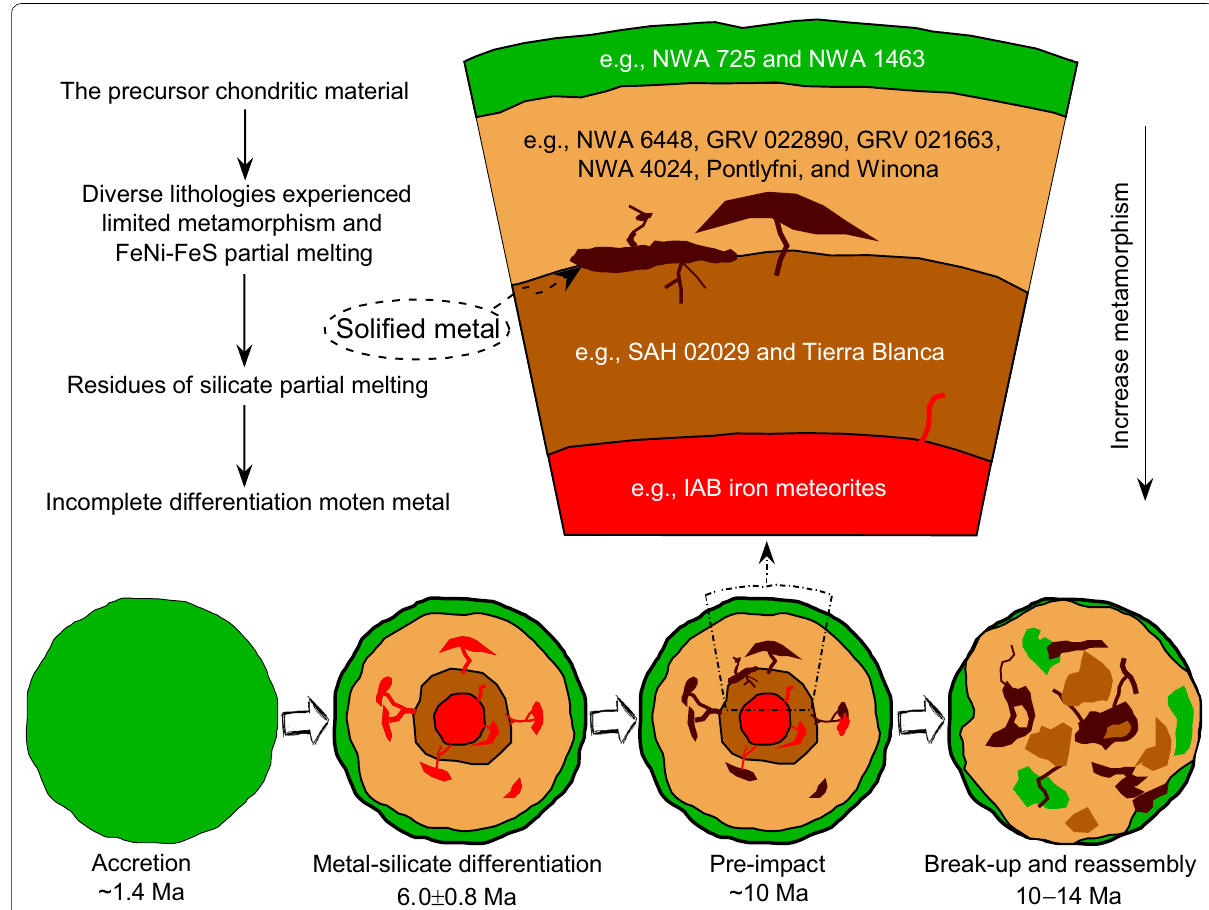
Fig. 7 The propositional layered structure of winonaite parent asteroid (Benedix et al. 2000; Hunt et al. 2018). The highly diverse textures and mineralogies of winonaites suggest a four-layered structure on the early winonaite parent asteroid (i.e., prior to the catastrophic impact breakup event): (1) surface layer consisting of precursor chondritic materials (e.g., NWA 725 and NWA 1463; Benedix et al. 1998); (2) subsurface layer composed of diverse lithologies that experienced limited metamorphism and FeNi–FeS partial melting (e.g., NWA 6448 and Pontlyfni; Floss et al. 2008); (3) deep residues of silicate partial melting (e.g., SAH 02029 and Tierra Blanca; Hunt et al. 2017); and (iv) the incomplete differentiation metal pools (e.g., the IAB iron meteorites; Hunt et al.